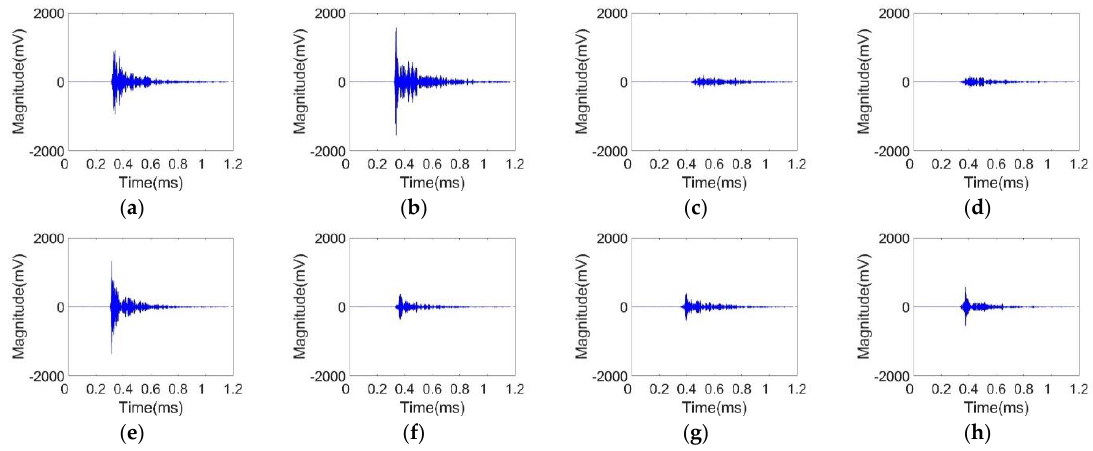
Figure 8. Time-domain impact signals after filtering for eight sensors: ( a ) sensor 1; ( b ) sensor 2; ( c ) sensor 3; ( d ) sensor 4; ( e ) sensor 5; ( f ) sensor 6; ( g ) sensor 7; ( h ) sensor 8.